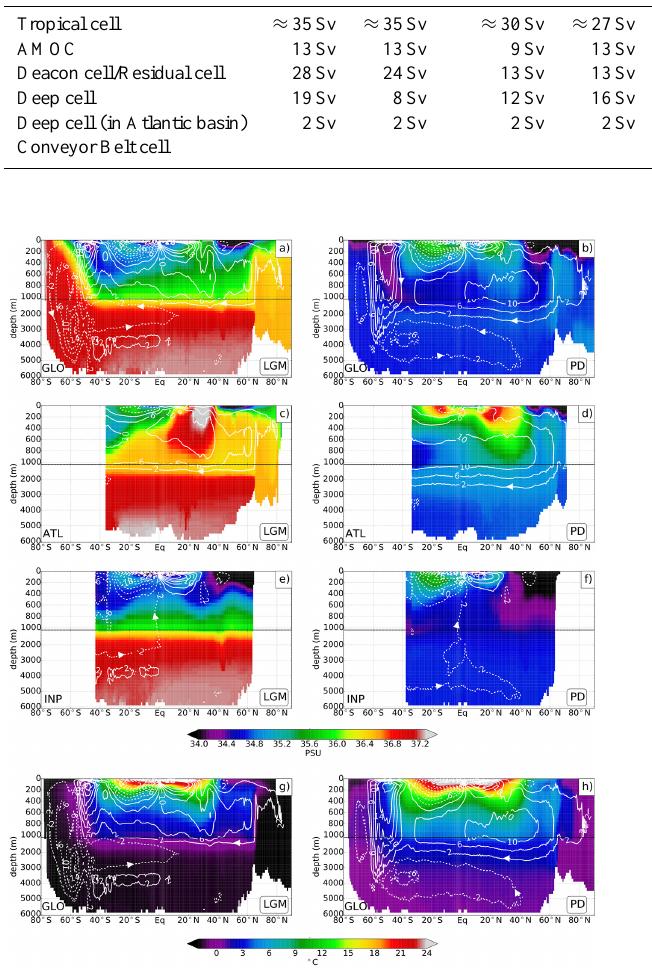
Figure 2. LGM and PD meridional overturning circulation in lati- tude–depth coordinates superimposed on the temporally and zon- ally averaged salinity in the Global Ocean (a, b) , the Atlantic basin (c, b) and the Indo-Pacific basin (e, f) . In the lower panels (g) and (h) , the global circulation is superimposed on the temporally and zonally averaged temperature in the Global Ocean. The contour interval for the circulation is 4Sv. Thick lines correspond to clock- wise circulations whereas dashed lines are for counter-clockwise motions. Upper diagrams show the temporally and zonally averaged meridional wind stress over the